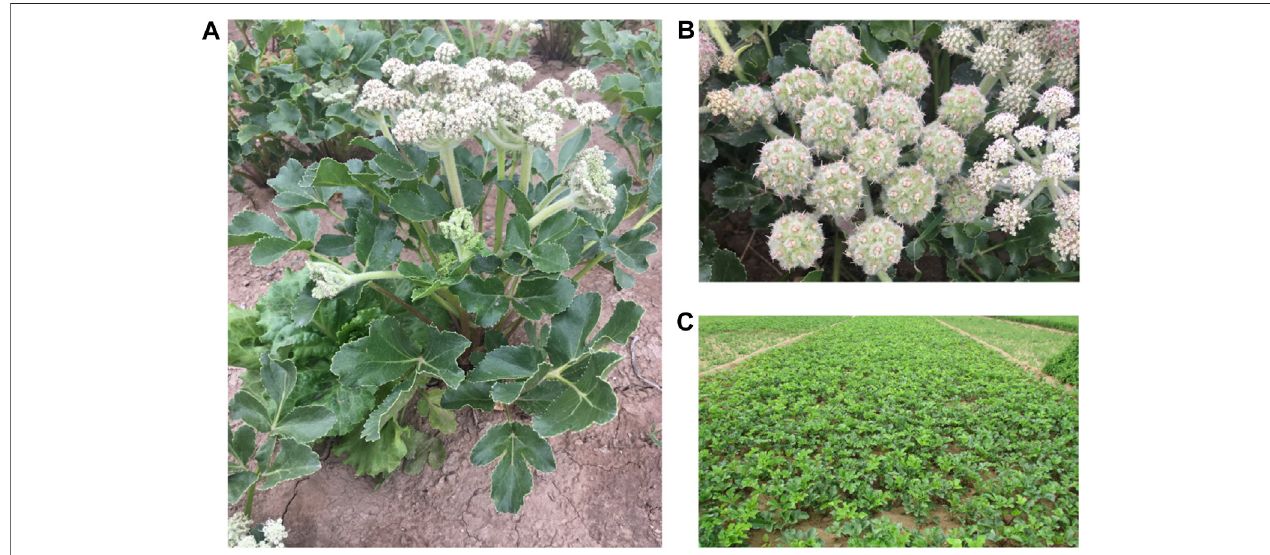
FIGURE1| Thecultivatedof Glehnialittoralis Fr.SchmidtexMiq. (A) ,umbeldetailsof Glehnialittoralis Fr.SchmidtexMiq. (B) and plantingbaseof Glehnialittoralis Fr. Schmidt ex Miq. (C) .